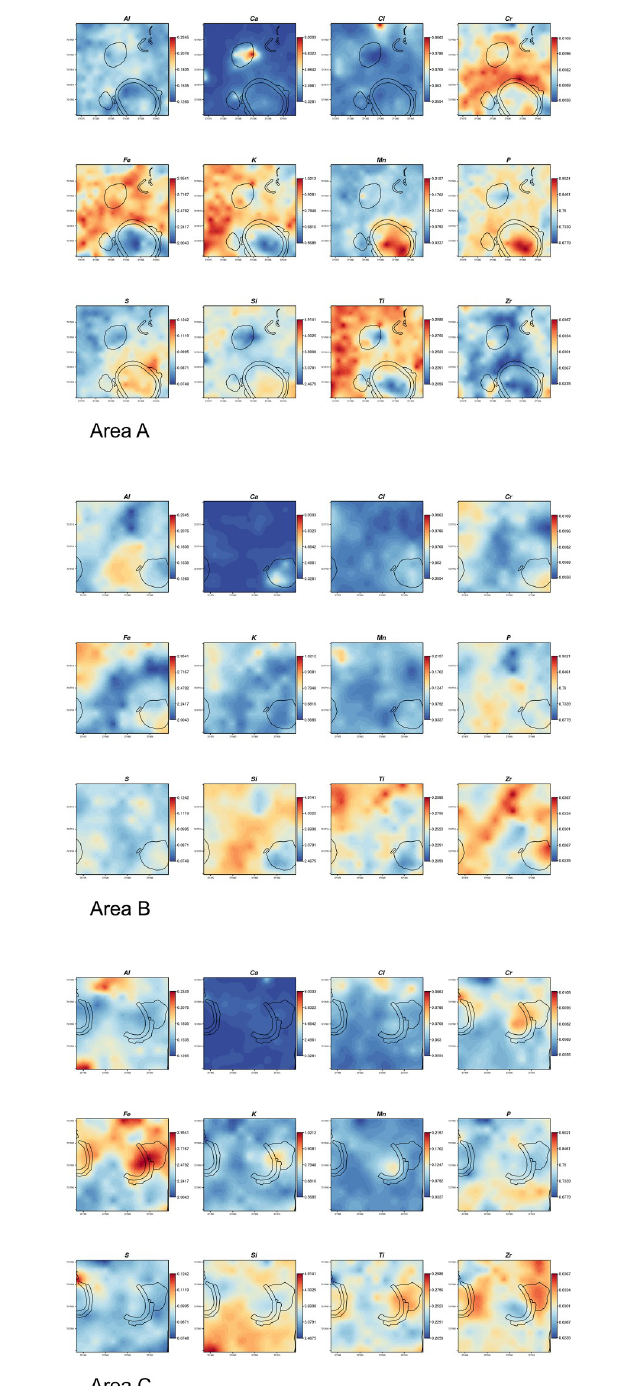
Fig 6. Co-Kriging map of elemental concentration at Seoke at areas A-C. Values express absolute concentrations (in %).